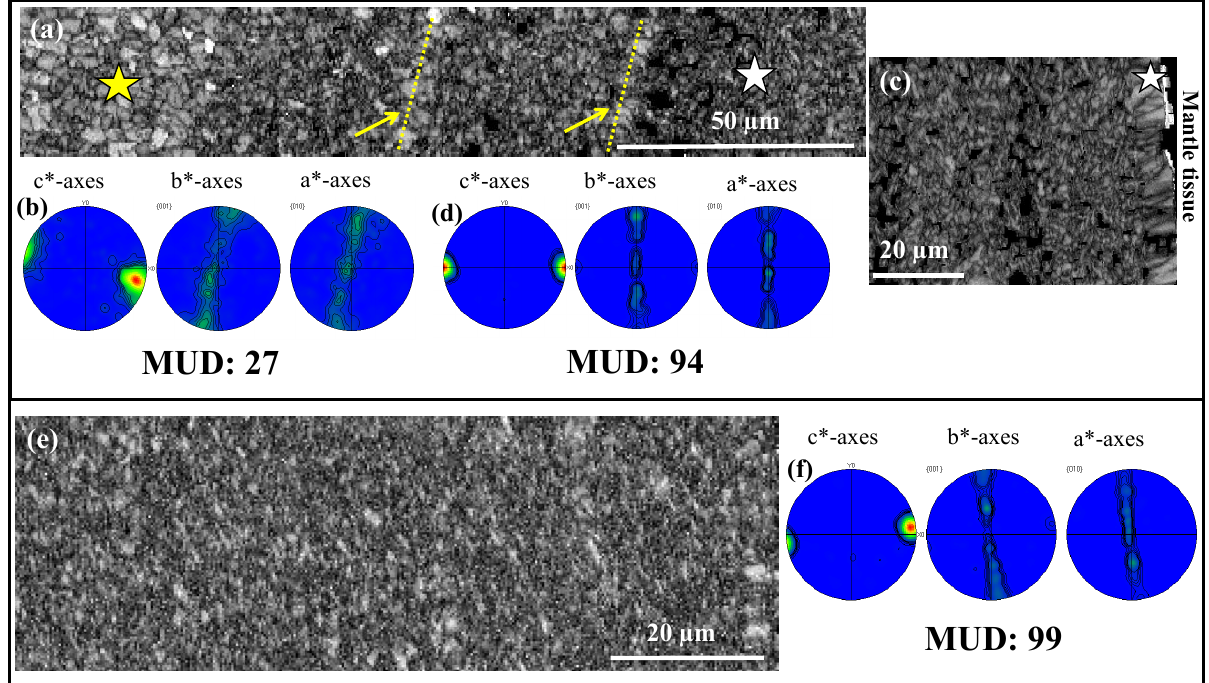
Figure 7. EBSD band contrast images (greyscale) and corresponding pole figures of hydrothermally altered (100 ◦ C for 28 days) Arctica islandica shell material with artificial meteoric fluid (a, b, c, d) and artificial burial fluid (e, f) . In (a) the change in shell microstructure is visible from the outer shell layer that contains large aragonite crystals (yellow star in a ) and many pores, in contrast to the inner shell layer, which consist of densely packed small aragonite crystallites (white star in a ). In (c) and (e) band contrast maps and pole figures are shown that were taken at the inner shell layer. As the pole figures and the high MUD values in (d) and (f) highlight, this part of the shell remains almost unaltered and the pristine Arctica islandica microstructure is kept. In (a) the two yellow arrows and the two dashed lines indicate the location of former growth lines where, in pristine shells, an increased amount of organic material is present. As the latter is destroyed during hydrothermal alteration, space becomes available for infiltration of fluids. For further details, see Fig.